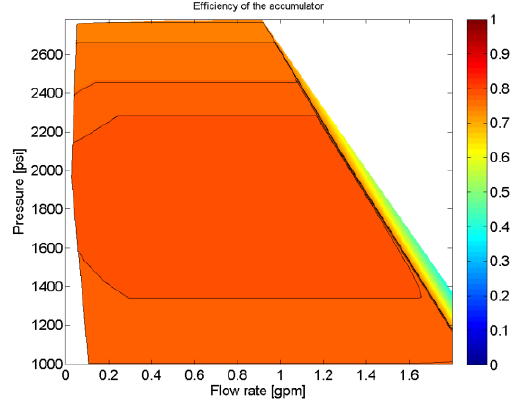
Figure 15. Instantaneous e ffi ciency of the hydraulic accumulator using a gear pump.